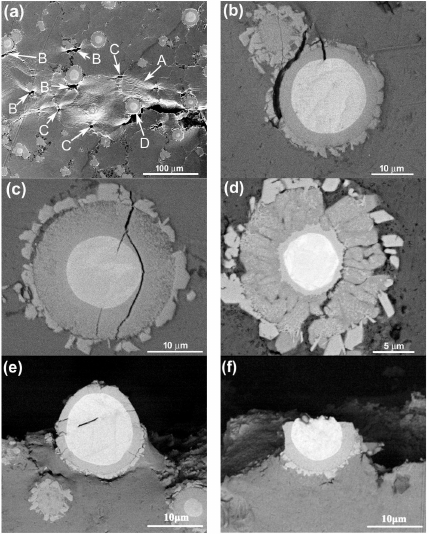
Figure 13. SEM micrographs of the composites thixoformed at reheating temperatures of ( a – c , f ) 600 ◦ C, ( d ) 605 ◦ C, and ( e ) 590 ◦ C during or after in situ tensile